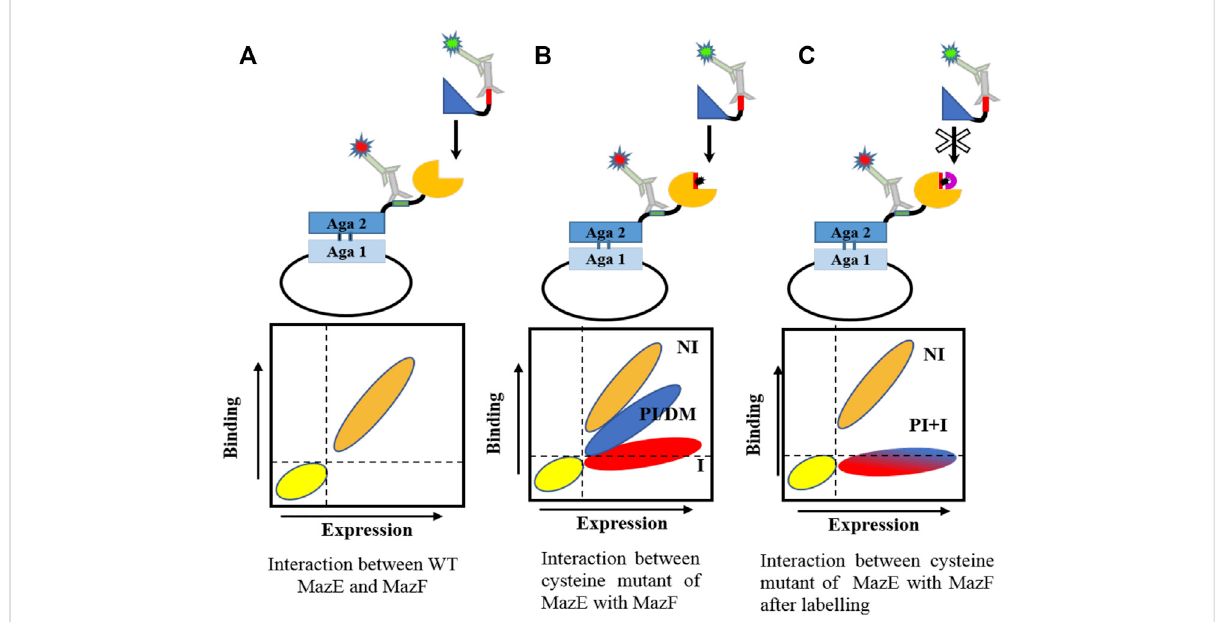
FIGURE 2 Schematicrepresentationofcysteinescanningmutagenesismethodology.CysteinemutantsofMazFandMazEareintroducedatthepredicted ligandbindinginterface. Themutantisdisplayedas afusion proteinonthesurfaceofyeast cellsanditsbindingto thecognate partner isobservedby fl ow cytometry (A) The interaction between WT toxin and antitoxin. (B) Introduction of a cysteine mutation in the protein may generate different populations, depending on the location of mutation. Non interacting residues are marked as NI, partially interacting as PI, destabilizing mutations as DM and hot spot residues as I. Mutation at non-interacting sites will not affect binding. However, mutation at the interface or destabilizingmutationswillresultinareducedbindingwhereinthehot-spotresidueswilllosebindingtoaveryhighdegreewhereasotherinterfacial residues may or may not show reduced binding. Destabilizing mutations typically occur at buried sites. (C) Labeling of cysteine with biotin-PEG2- maleimide should result in loss of binding of all interacting residues. Buried sites are expected to be shielded from